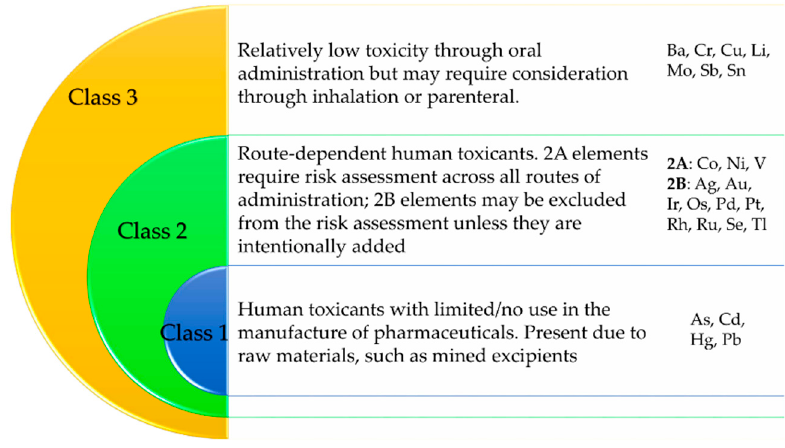
Figure 2. Element classification of the ICH Q3D(R1) guideline. Based on ICH Q3D(R1) [30].